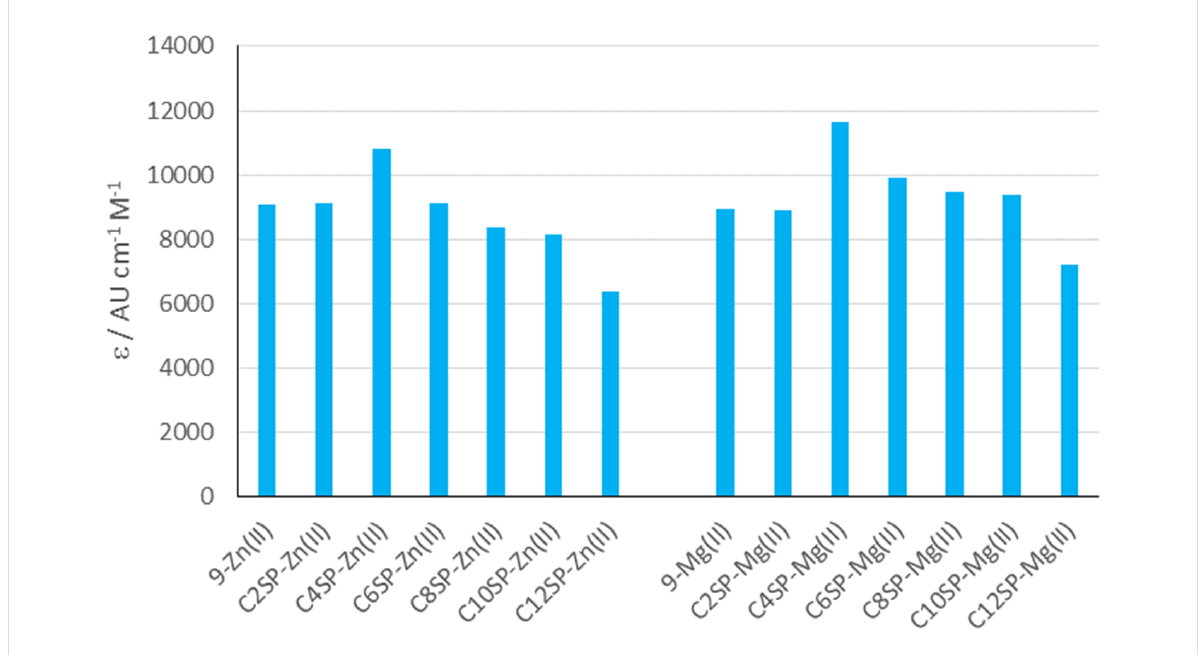
Figure 4: ε for MC–M 2+ complexes of C2SP – C12SP and 9 : (left) with Zn 2+ ; (right) with Mg 2+ . Values for ε were calculated by application of 1 H NMR- derived values for [MC–M 2+ ] to UV–vis spectroscopy-derived absorbance intensities of MC–M 2+ (see Figure 3).